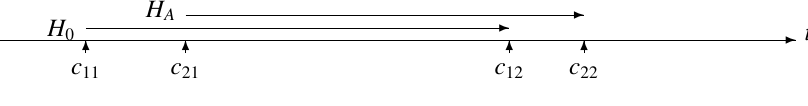
Figure 3. Two overlapping confidence